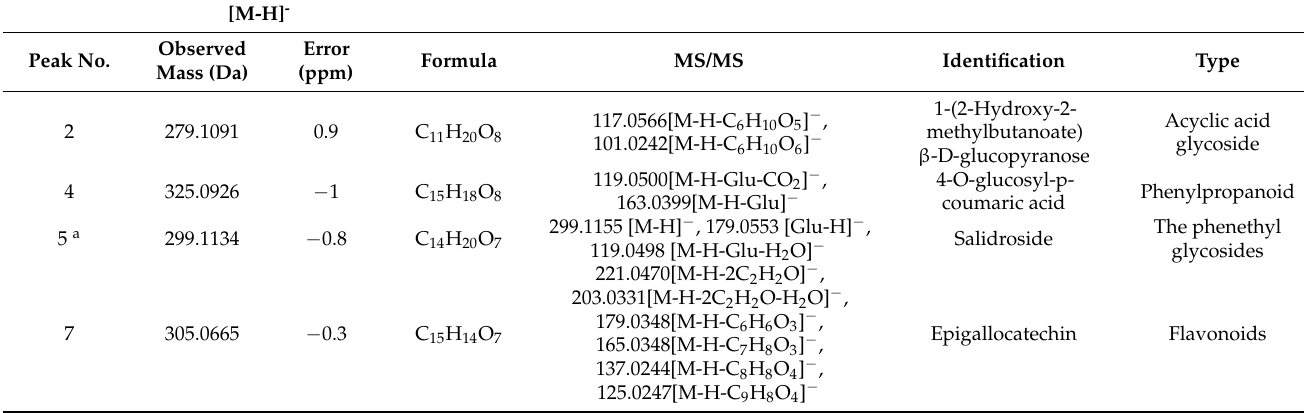
Table 1. Identification of the characteristic peaks of Rhodiola by UHPLC-Q-TOF-MS/MS in negative ion mode. [M-H] - Peak